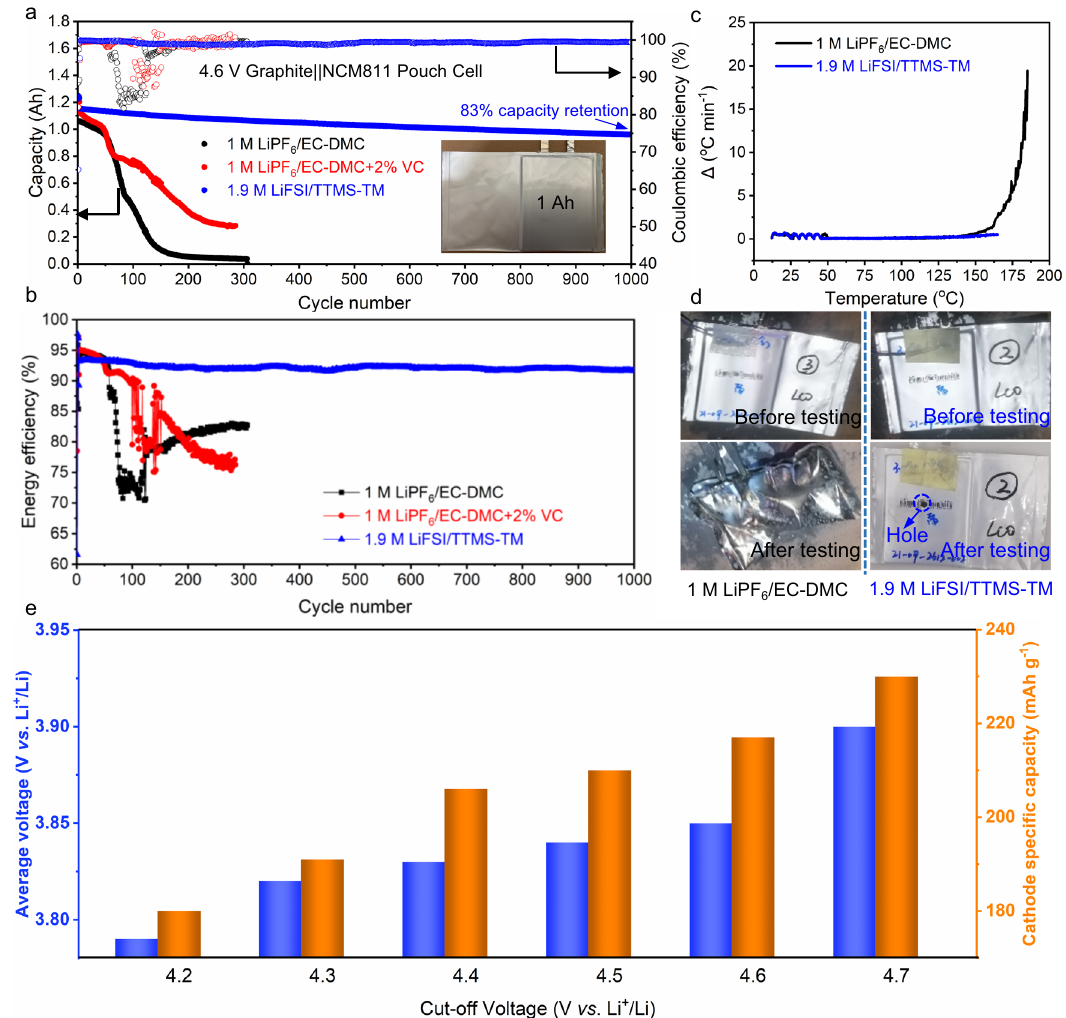
Fig. 6 | Practical application of the 1.9M LiFSI/TTMS – TM electrolyte in pouch cells. a Cycling performance of 1-Ah graphite||NCM811 pouch cells. b Energy ef fi - ciencyof 1-Ahgraphite||NCM811 pouch cells. c ARCtest forfully charged graphite|| NCM811pouchcells. d Opticalmorphologyofgraphite||LCOpouchcellsbeforeand